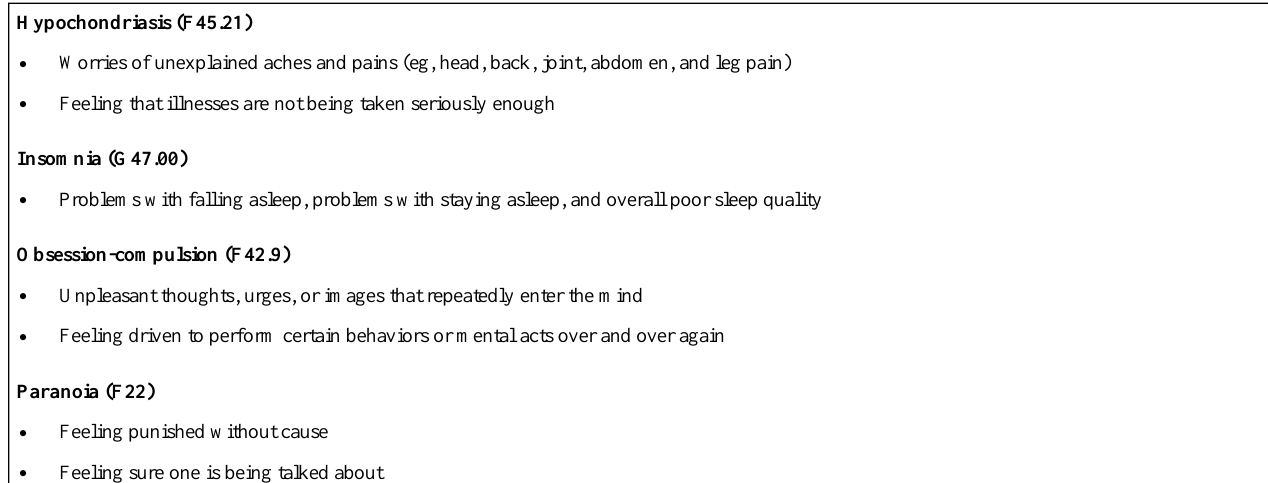
Textbox 1. Descriptions of International Classification of Diseases, Tenth Revision diagnostic categories and symptoms that were identified via digital